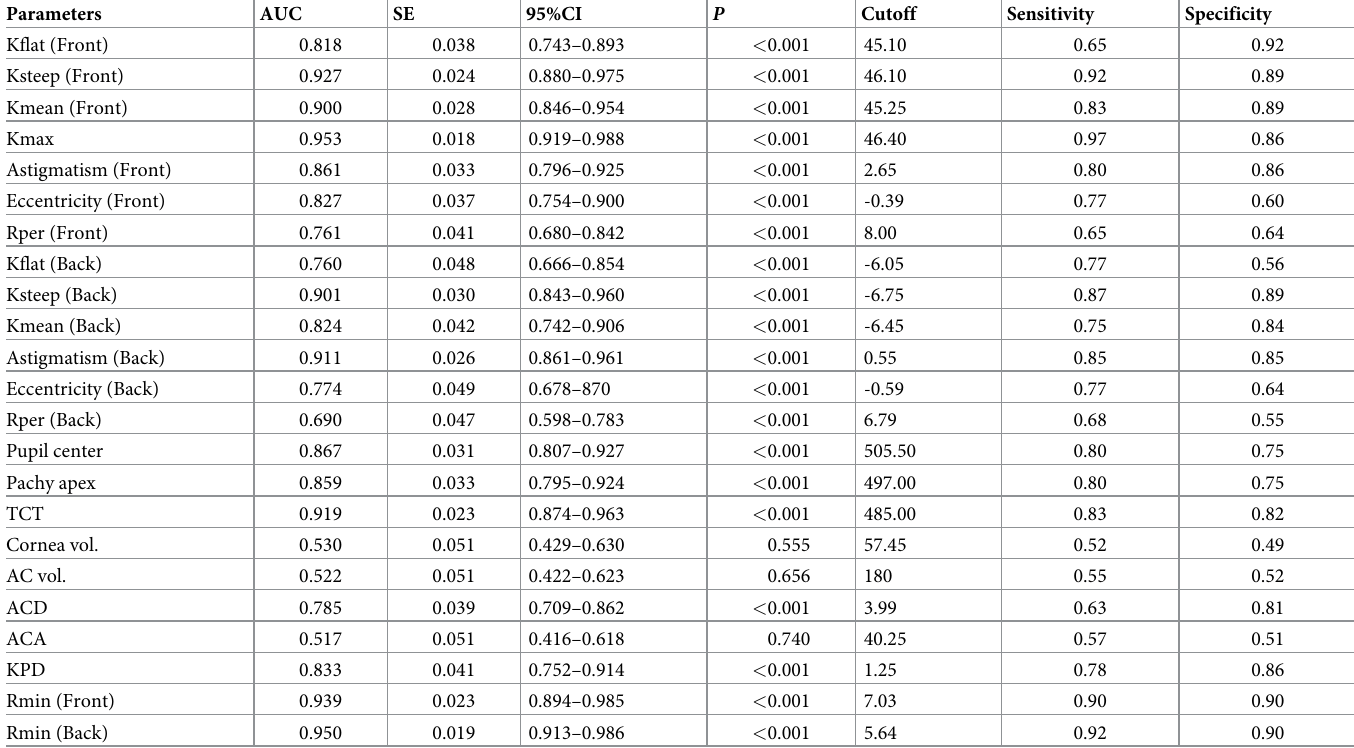
Table 4. Receiver Operating Characteristic (ROC) curve analysis of topographic parameters of keratoconic and high myopic astigmatic